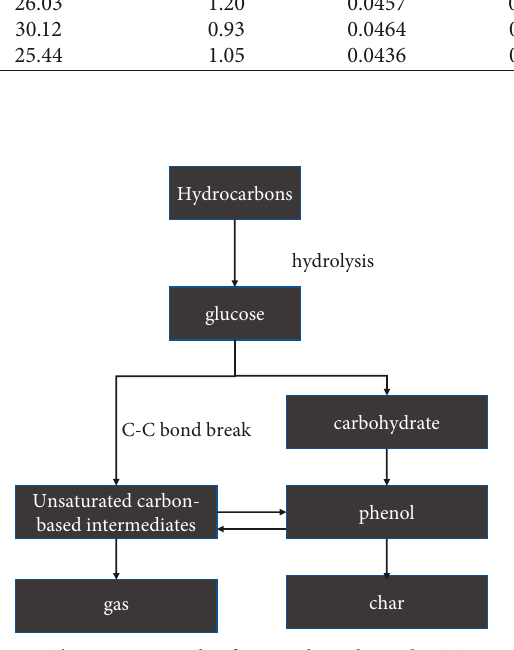
Figure 5: The reaction path of microalgae through HTL process.